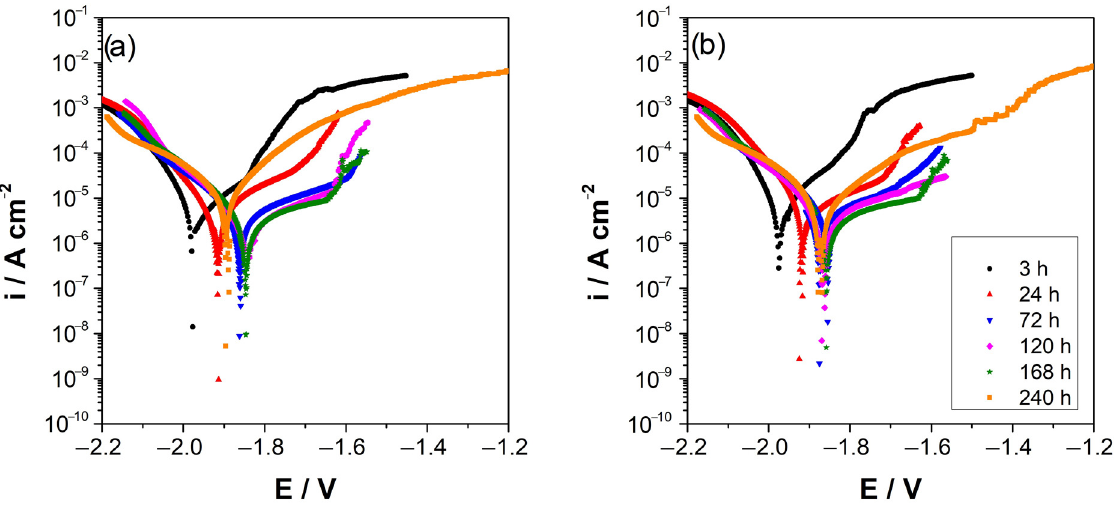
Figure 4. Potentiodynamic polarization curves of AZ31 alloy immersed in 0.1 M Na 2 SO 4 , ( a ) AZ surface, ( b ) AZ + Ar-P surface. All potentials refer to MSE electrode. Table 2. Electrochemical parameters of AZ31 alloy in Na 2 SO 4 0.1